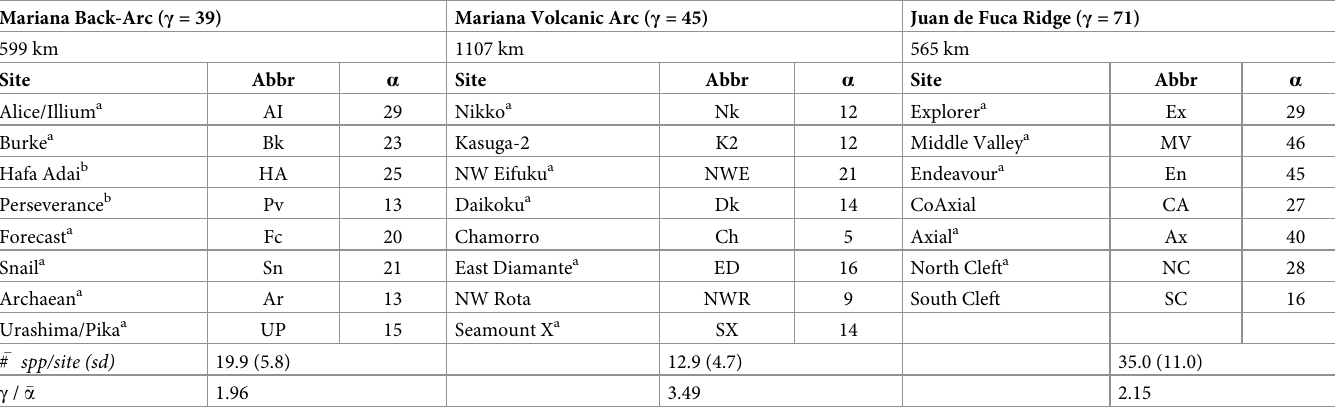
Table 3. Species richness measures for the three study vent systems.